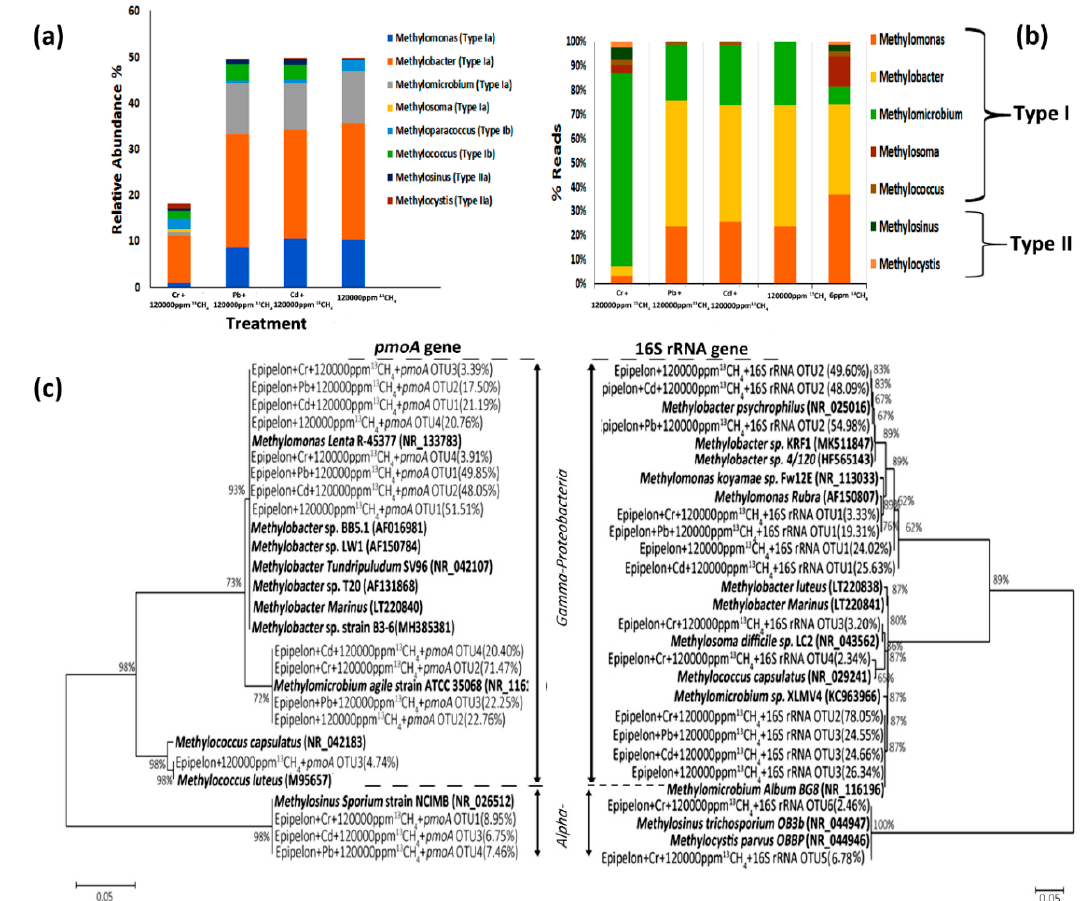
Figure 6. Methanotrophic community compositions of 13C-labeled MOB based on phylogenetic tree analysis of 16S rRNA and pmoA genes. ( a ) Percentage of type Ia, Ib, II and IIa methanotrophs were computed from the 13C-labeled genes. ( b ) Percentages of type I and II MOB were determined from16S rRNA high throughput sequencing of the 13C-labeled genes ( c ) Neighbor-joining phylogenetic tree depicts the phylogenetic relationship of dominant OTU sequences with the known MOB sequences from GenBank. The percentages illustrate the relative sequence abundance of each OTU to the total MOB-affiliated 16S rRNA or pmoA genes. Bootstrap values higher than 60% are pointed at the branch nodes.